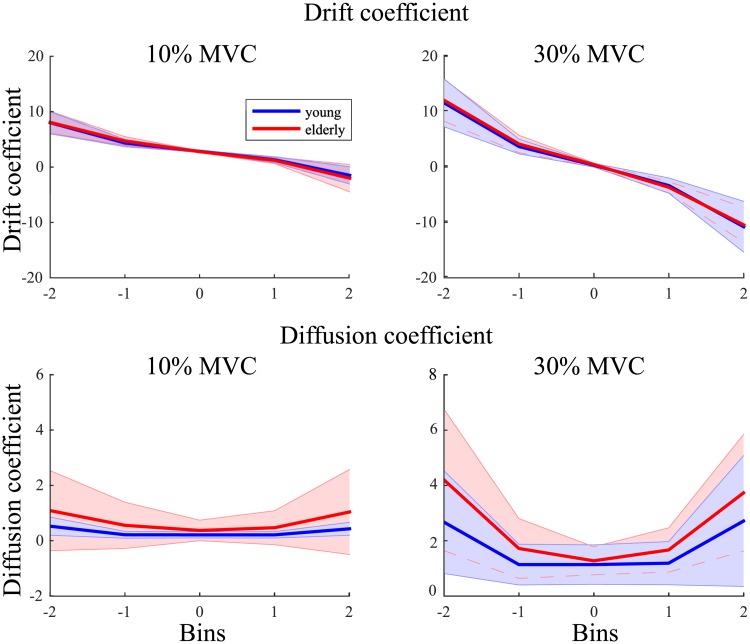
Drift and diffusion coefficients for a constant force task at 10% and 30% maximum voluntary contraction for young (blue) and elderly (red).The shaded area represents the standard deviation.